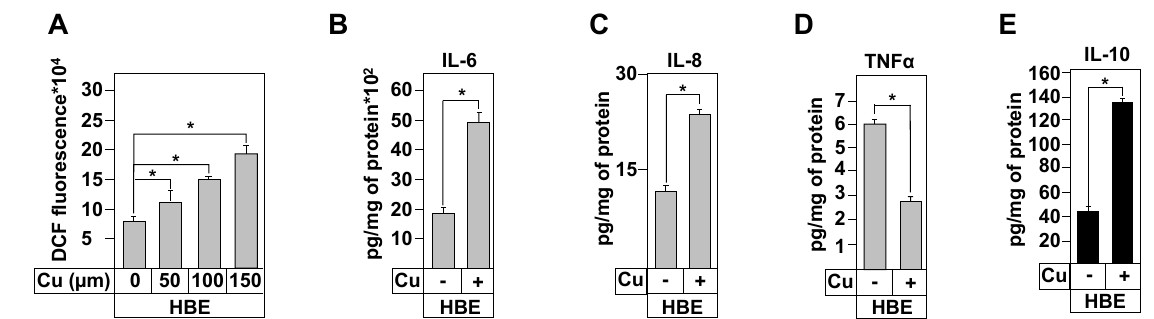
Figure 7. Effect of copper treatment on the inflammation profile of healthy and CF bronchial cells. ( A ) Measurement of ROS levels in HBE cells following treatment with the indicated copper (Cu 2+ ) concentrations. Cells were incubated with 50 µM H2DCFDA for 45 min. The conversion of H2DCFDA to fluorescent DCF was measured at λ ex/ λ em of 495/527 nm. Measurement of IL-6 ( B ), IL-8 ( C ), TNF α ( D ), and IL-10 ( E ) concentrations in the culture media (grey chart) and in protein extracts (black chart) of HBE cells after treatment with 100 µM of Cu, during 24 h. Cytokine levels were assayed using ELISA tests. Concentrations are in pg/mg of protein extracts. Values overwritten with stars are significantly different from the control ( p < 0.05). Data are expressed as mean ± SE ( n = 6).